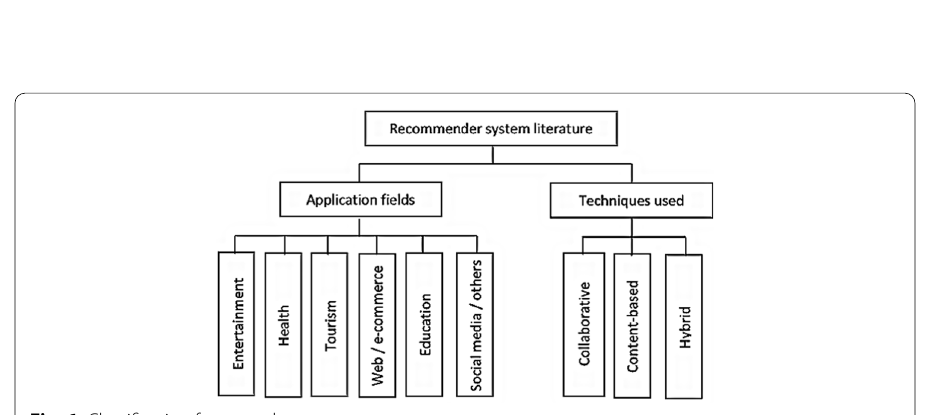
Fig. 5 PRISMA flowchart of the inclusion and exclusion process. Abstract and content not suitable to the study: *The use or application of the recommender system is not specified: